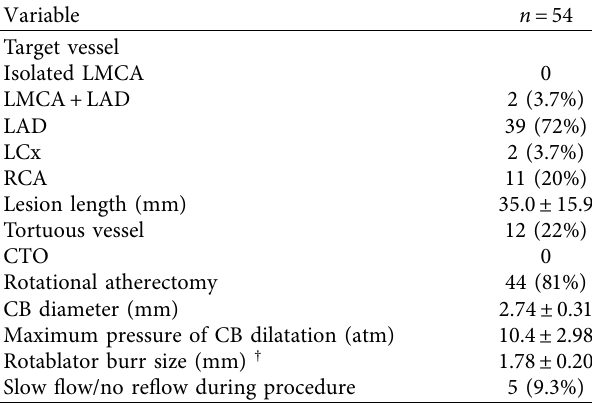
Table 2: Baseline lesion characteristics and procedure